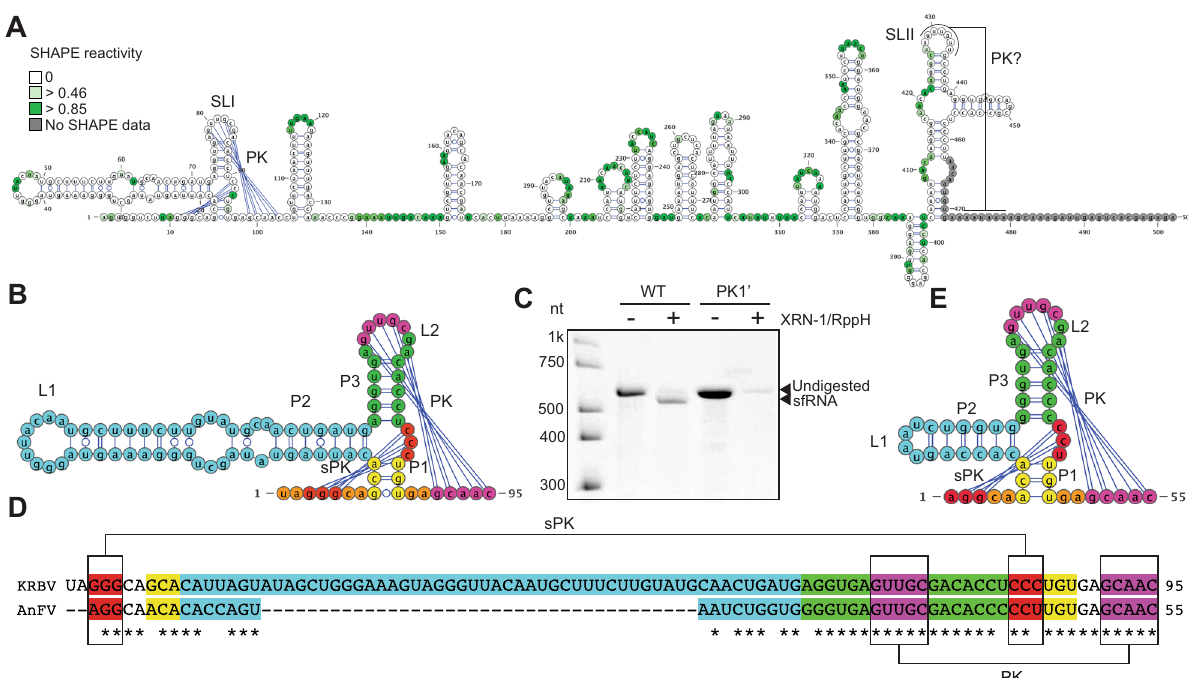
Fig. 5 Anopheles -associated ISFs contain a single copy of xrRNA, which shares features of class 1a and class 1b xrRNAs. A Secondary structure of KRBV 3 ’ UTR generated using SHAPE-assisted folding. Shading intensity indicates NMIA reactivity. Values are the means from 3 independent experiments, each with technical triplicates. SL – stem loop, PK -pseudoknot. B Secondary structure of KRBV xrRNA. Each element of the secondary structure is shown in colour. C In vitro XRN1 resistance assay with WT and mutated KRBV 3 ’ UTRs. PK1 ’ mutation was GUUGC - > CAACG change of PK-forming nucleotides in the L2 loop of the SLI. The experiment was repeated three times with similar results. D Sequence alignment of KRBV and AnFV1 xrRNAs. The colour coding matches ( B ) and shows conserved structural elements. E Predicted secondary structure of AnFV1 xrRNA. The conserved structural elements are shown in colours that match ( D